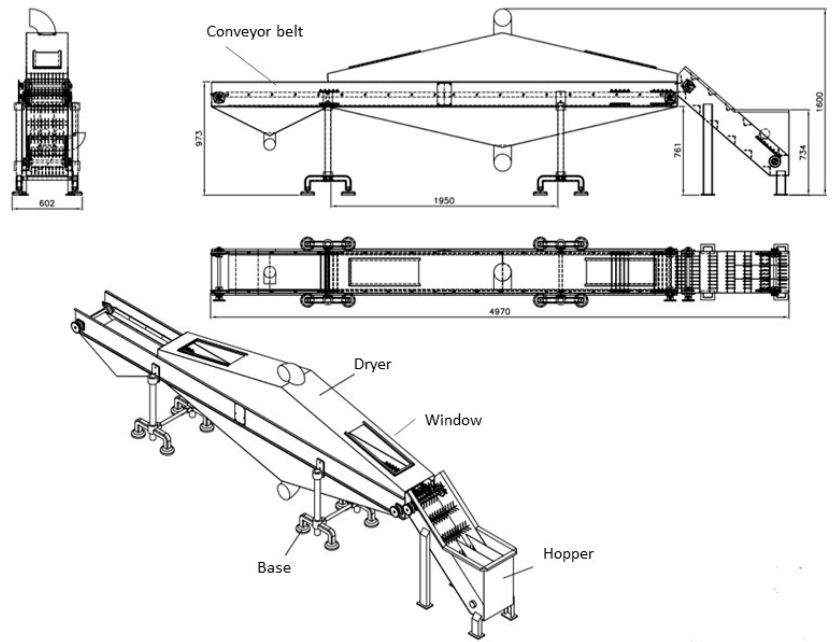
Figure 1. Overview of coating equipment.